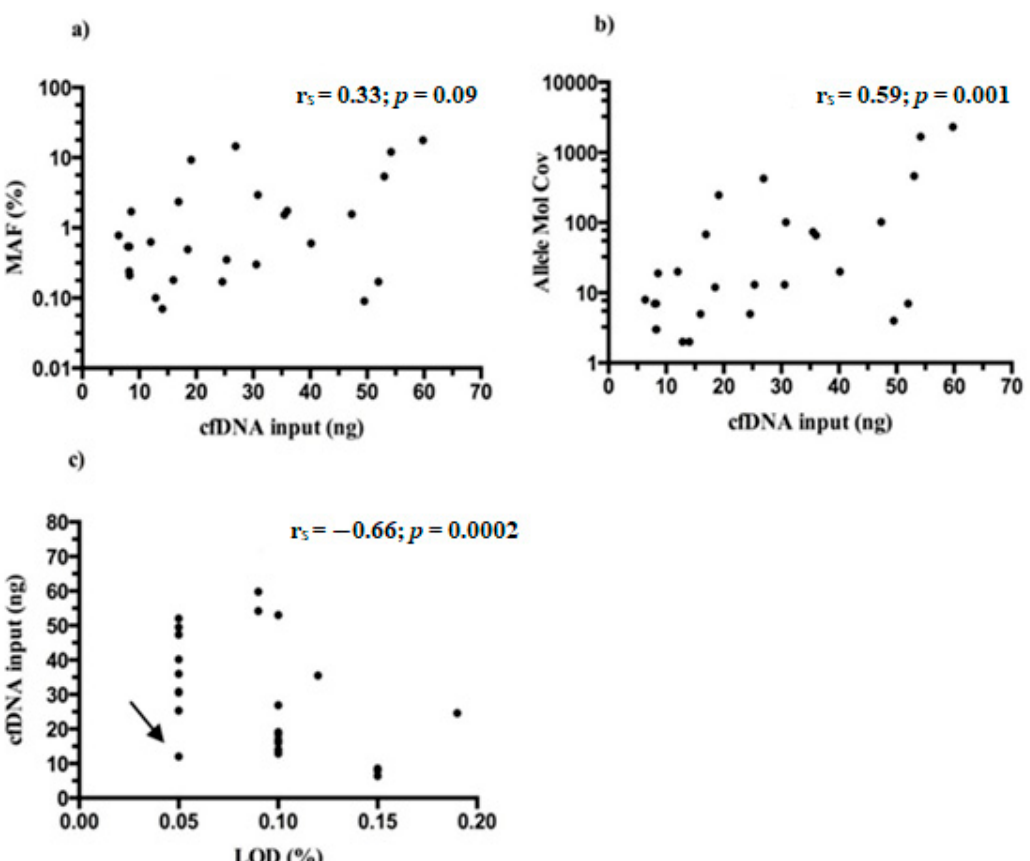
Figure 6. CfDNA input and TVC parameters from Thr790Met positive samples. ( a ) No significant correlation between cfDNA and MAFs was reported (r s = 0.33; p = 0.09). Moderate correlations were found between the cfDNA input and: ( b ) the number of mutated DNA molecules (Allele Mol Cov) (r s = 0.59; p = 0.001); ( c ) the LoD of Thr790Met variant (r s = − 0.66; p = 0.0002). The arrow indicates a peculiar case of a 0.05% LoD reached with only 12 ng of cfDNA input.